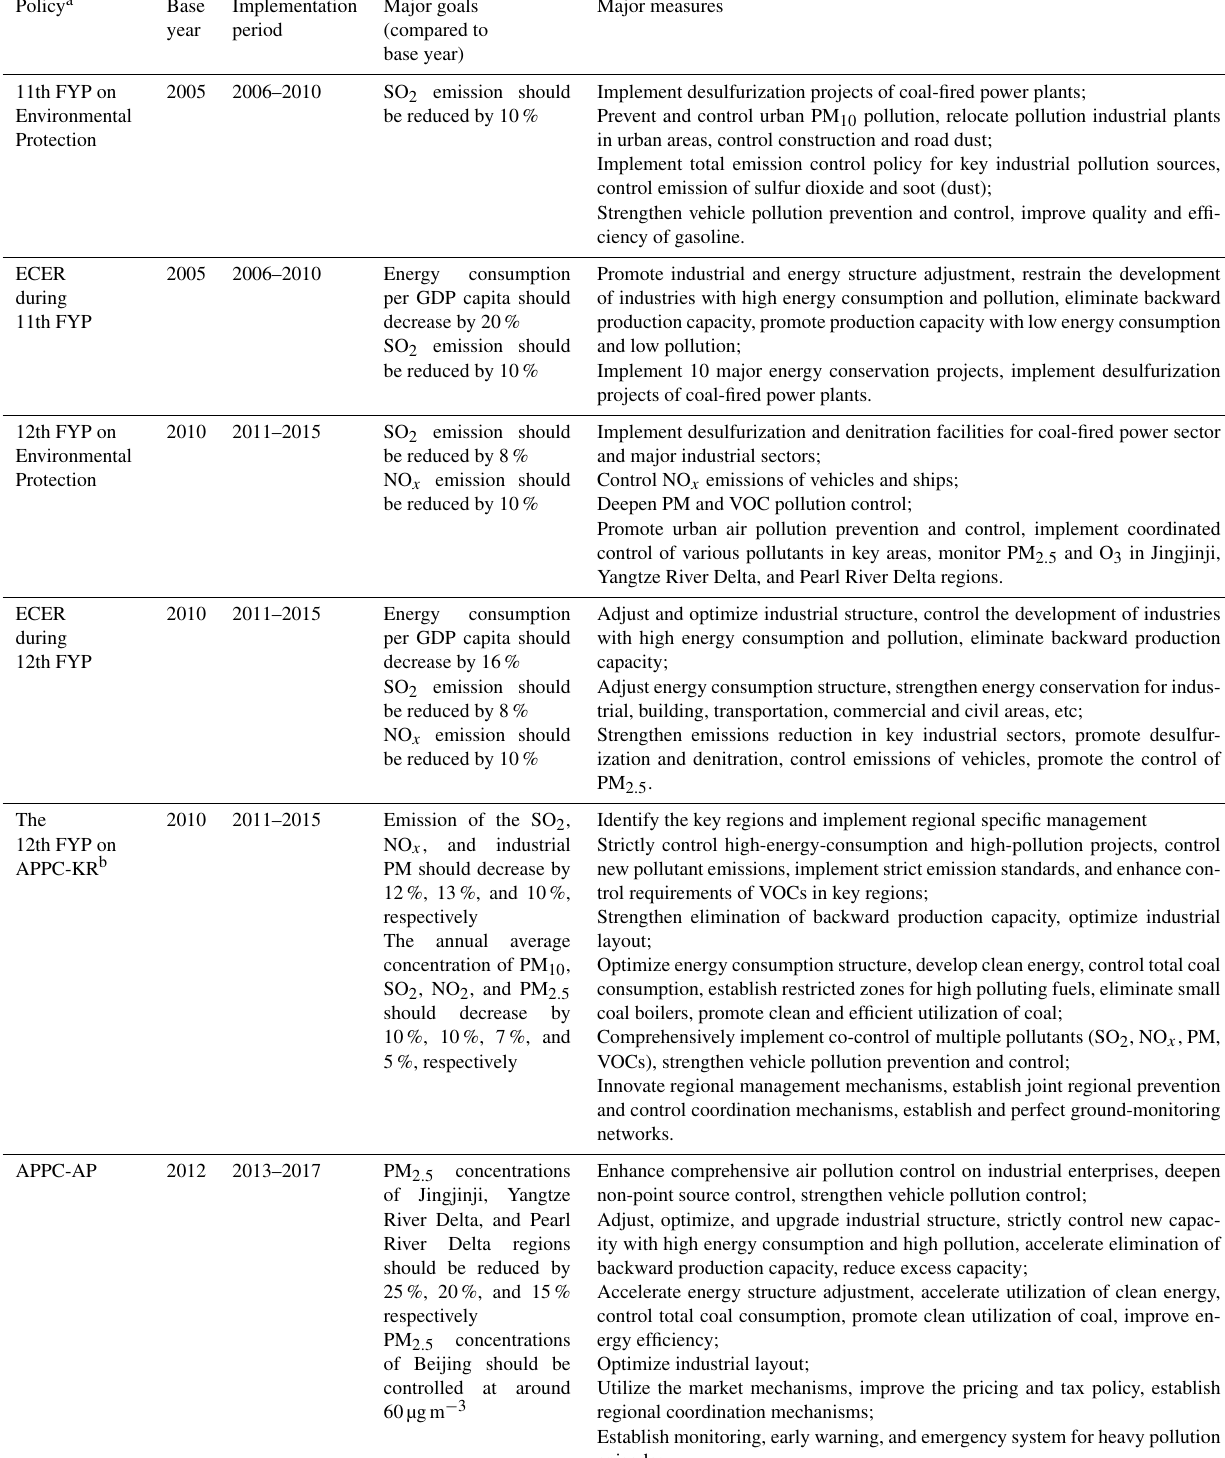
Table 1. Overview of major air pollution control policies in China from 2005 to